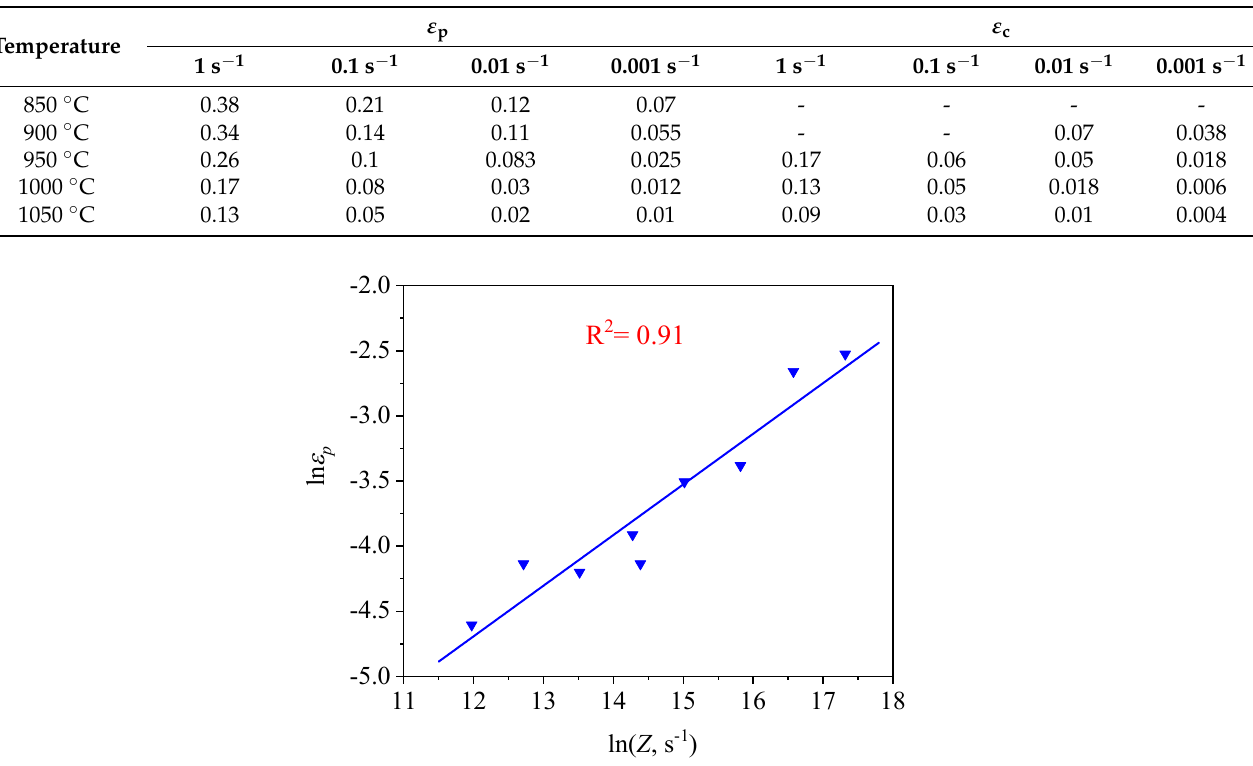
Table 1. The values of ε p and ε c under various hot-working conditions.